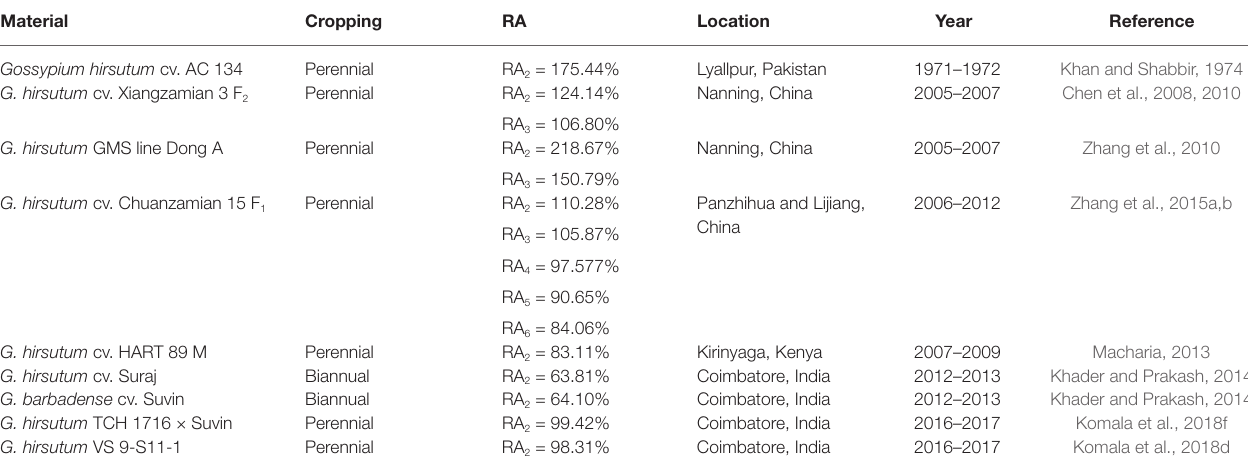
TABLE 2 | Ratooning ability of seed-cotton yield in different trials. Material Cropping RA